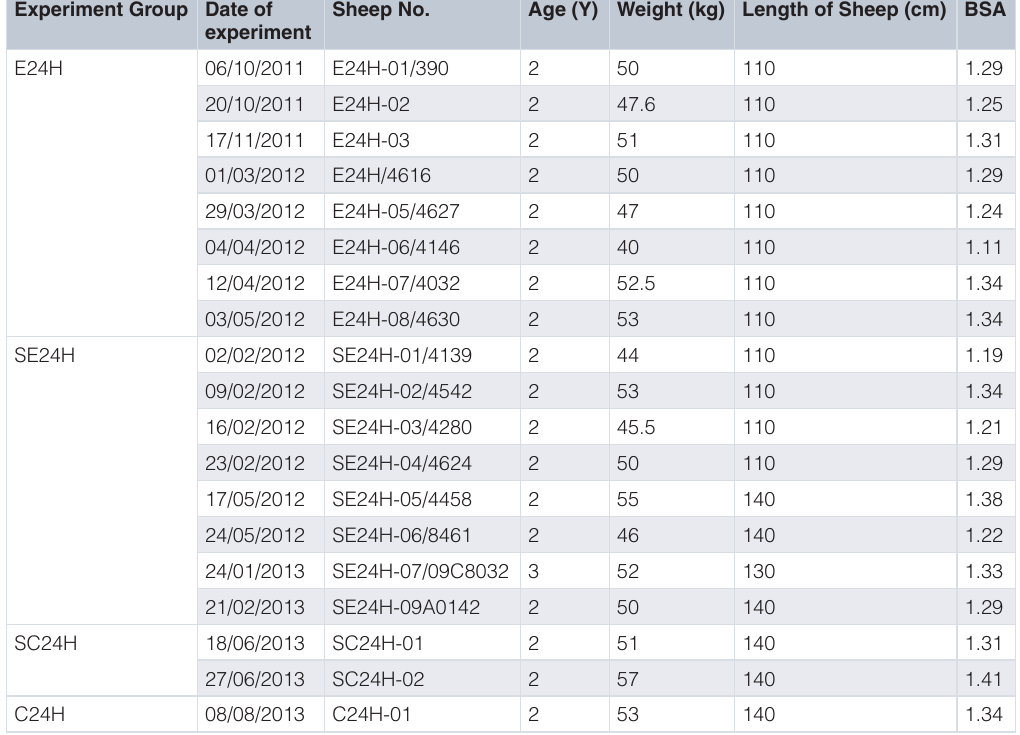
Table 1 legend: BSA = Body surface area; E24H = uninjured sheep treated with extracorporeal life support (ECLS) for 24 hours (uninjured/treated); SE24H = sheep with acute smoke-induced lung injury treated with ECLS for 24 hours